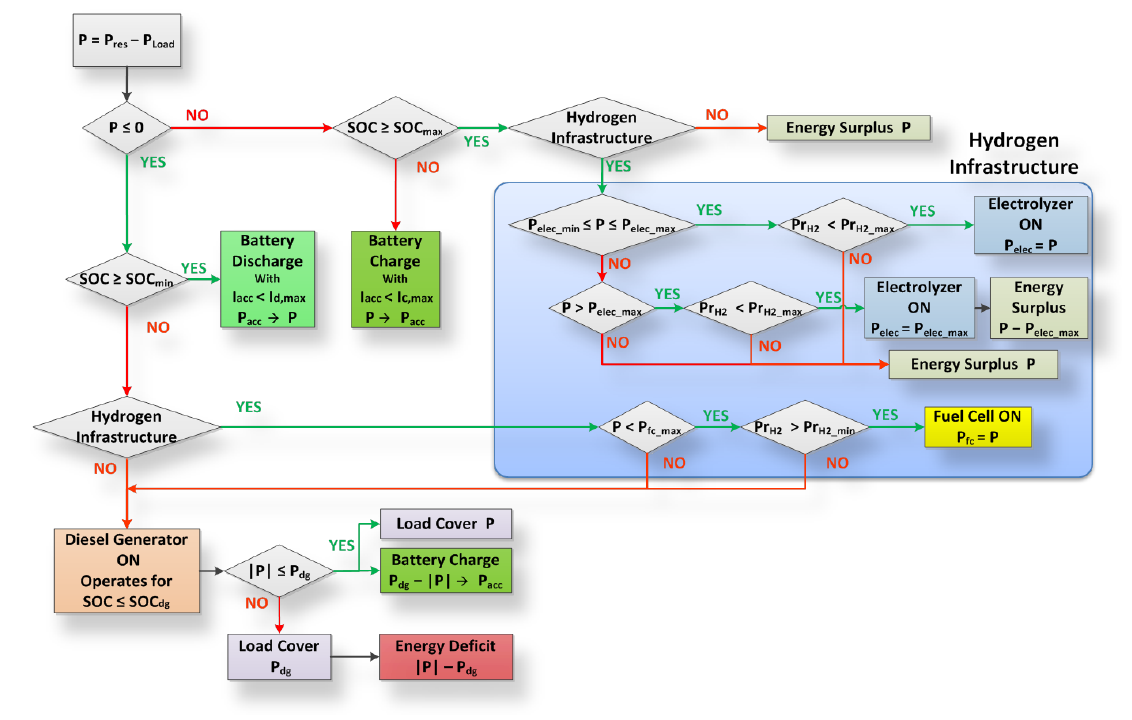
Figure 2. Energy management strategy algorithm.